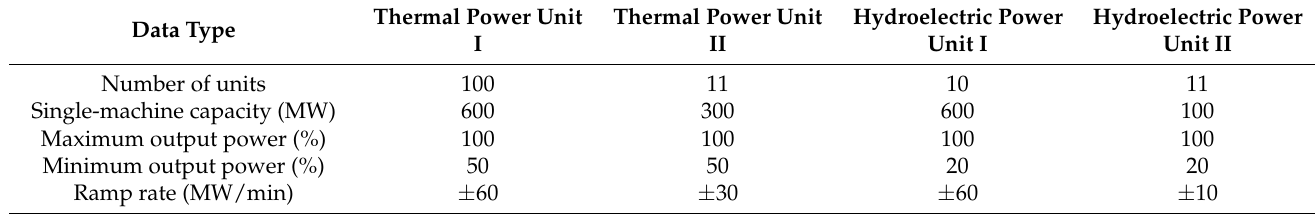
Table 2. The configuration information of conventional units.